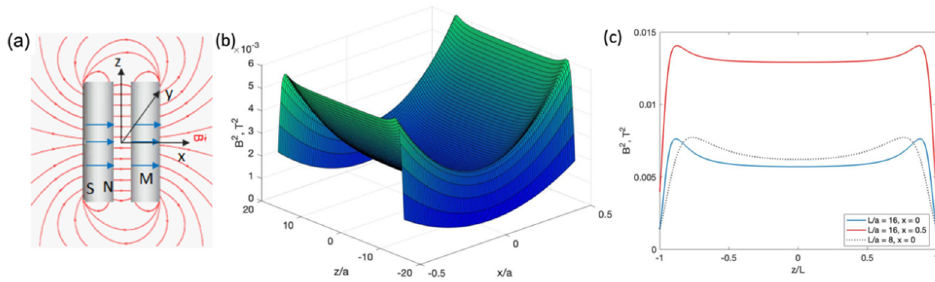
Figure 8. ( a ) Magnetic field configuration from a pair of cylindrical magnets polarised along the diameter. ( b ) Two-dimensional energy plot represented by the square of the magnetic field induction ( B 2 ) from a pair of microwires in the x - z plane. y / a = 1. The magnet parameters correspond to Co- based amorphous microwire (see Figure 4) with radius a = 10 µ m, length 2 L = 32 a , magnetisation M = 0.5 MA / m , and distance between wires d = 3 a . ( c ) Distribution of B 2 along the wire length ( z -axis) for two different lengths, L / a = 8 and 16. x = 0 and 0.5/ a , y / a = 1. A saddle-shaped minimum with a wide plateau is formed between the wire edges, and the energy peaks near the edges are sharper with increasing length. Moving away from the center point on the x-axis reduces these